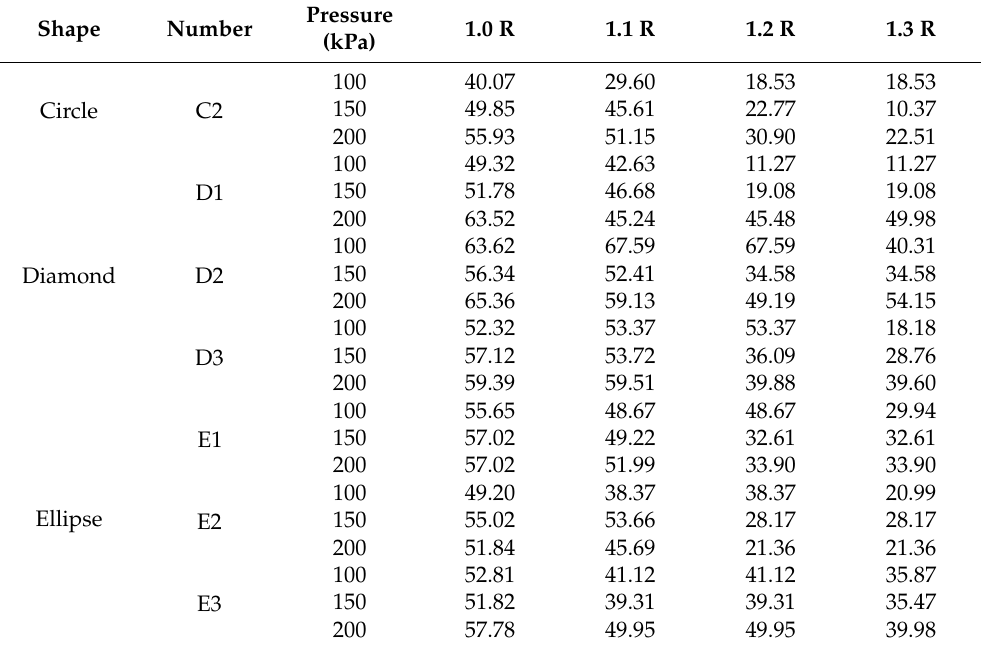
Table 7. Uniformity coefficient of the kinetic energy intensity distribution for each nozzle under different combination